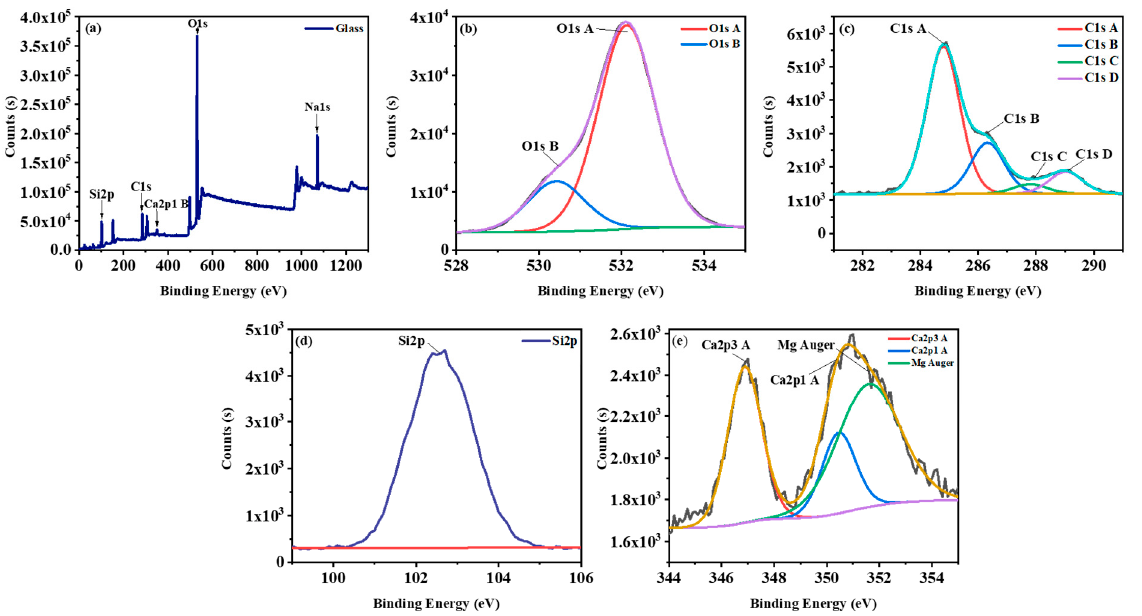
Figure 4. ( a ) XPS survey scan of glass from automotive waste and typical high-resolution XPS spectra of ( b ) O1s, ( c ) C1s, ( d ) Si2p, ( e ) Ca2p.